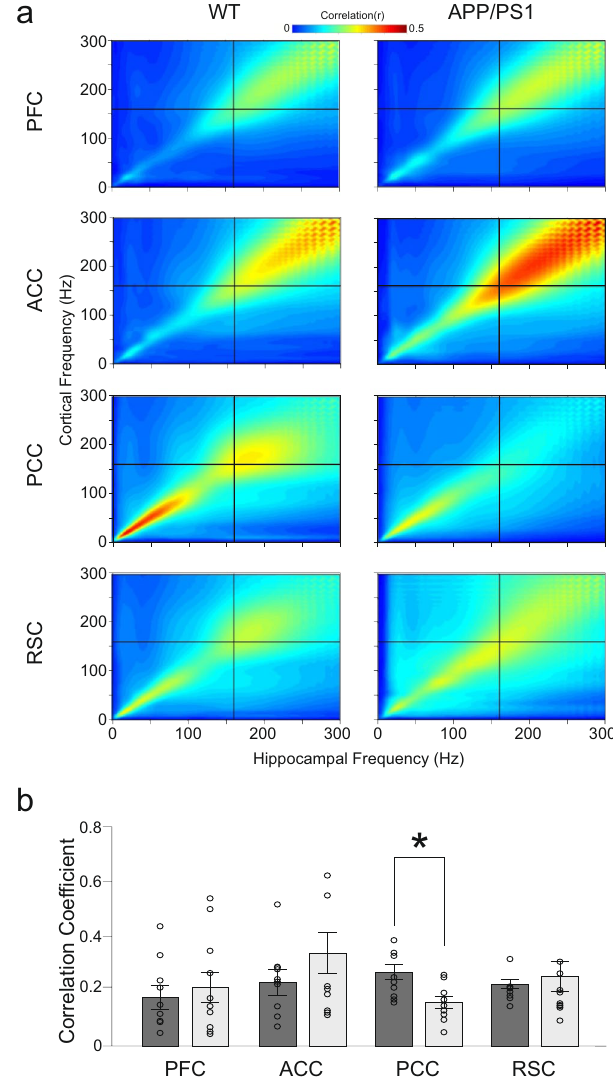
Figure 5. Comparison of cross-frequency power coupling between cortex and hippocampus in WT and APP/ PS1 mice. ( a ) Comodulograms showing coupling between different cortical areas and CA1 during occurrence of cortical ripples, after learning session, averaged over 9 WT and 10 APP/PS1 animals. The cross indicates the mean frequency of cortical ripples. ( b ) Mean correlation coefficient between hippocampal and cortical activity in the cortical ripple frequency band (140–180 Hz). No statistical differences between WT (dark bars) and APP/ PS1 group (light bars) were found except higher synchronization between CA1 and PCC in WT compared to APP/PS1 animals (P = 0.014, Wilcoxon